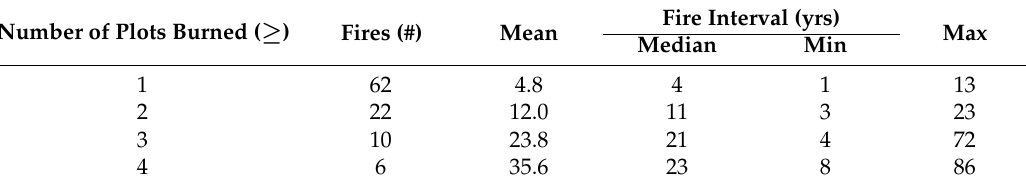
Figure 4. The plot composite fire chronologies for all fires at each plot. The multi-plot fire composite (red) represents all fires recorded by >2 plots. The grey shaded region is the common period used for analysis. Fires that burned in all three watersheds are highlighted in orange (1664, 1715, and 1842). Table 3. The fire interval statistics for fires that burned one or more plots in the Taos Valley Watersheds (1600–1899).